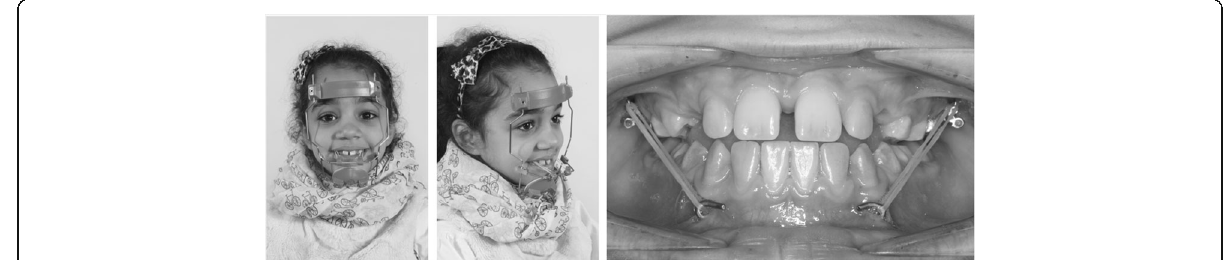
Fig. 1 Exemplary presentation of a patient wearing a facemask (left) and a Mentoplate